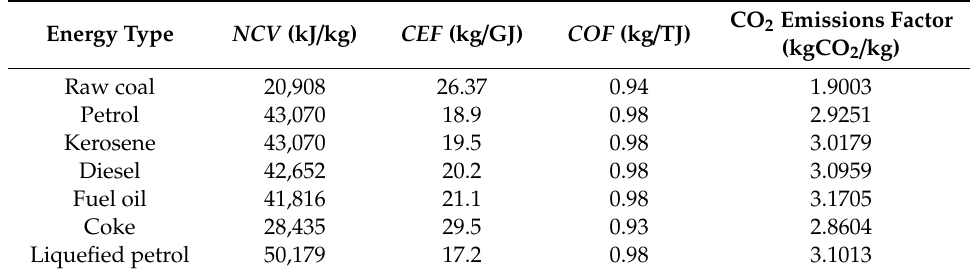
Table 1. Results for the main fuel coal folding coe ffi cient, calorific value, carbon content, and CO 2 emissions coe ffi